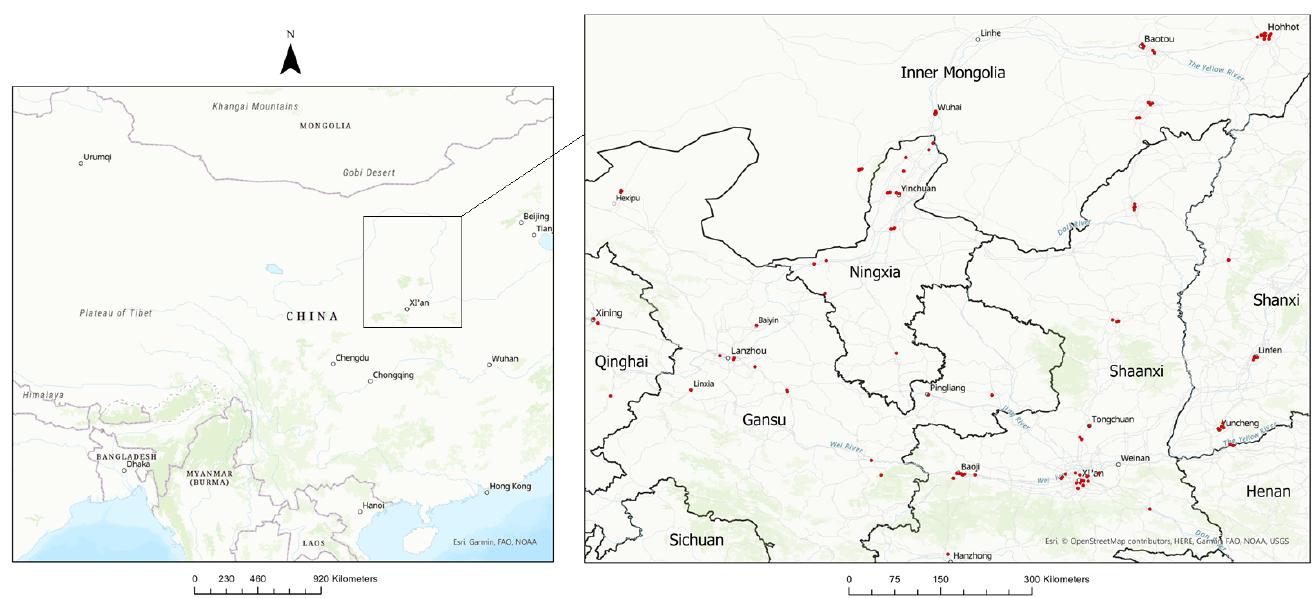
Figure 1. Location and distribution of air quality monitoring sites in study area.